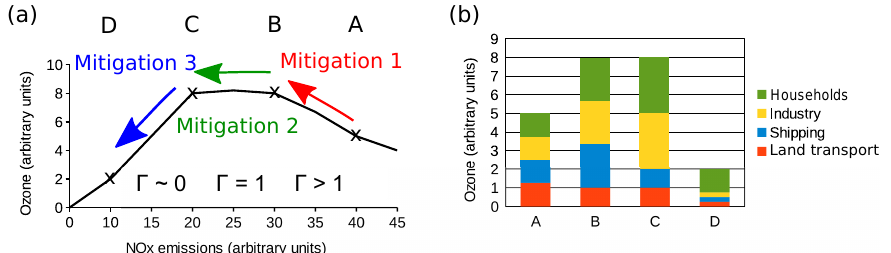
Figure 6. Idealized example explaining the difference in the perturbation and the tagging approach for the evaluation of mitigation increases. (a) The dependency between NO x emissions and ozone (both in arbitrary units). Three different mitigation options are indicated by the coloured arrows. In addition, the approximate value of (cid:48) (see text for definition) is given. (b) The contribution of the ozone concentration at the four marked points in (a) . In this example it is assumed that only four emission categories exist, emitting the same amount of emissions at point